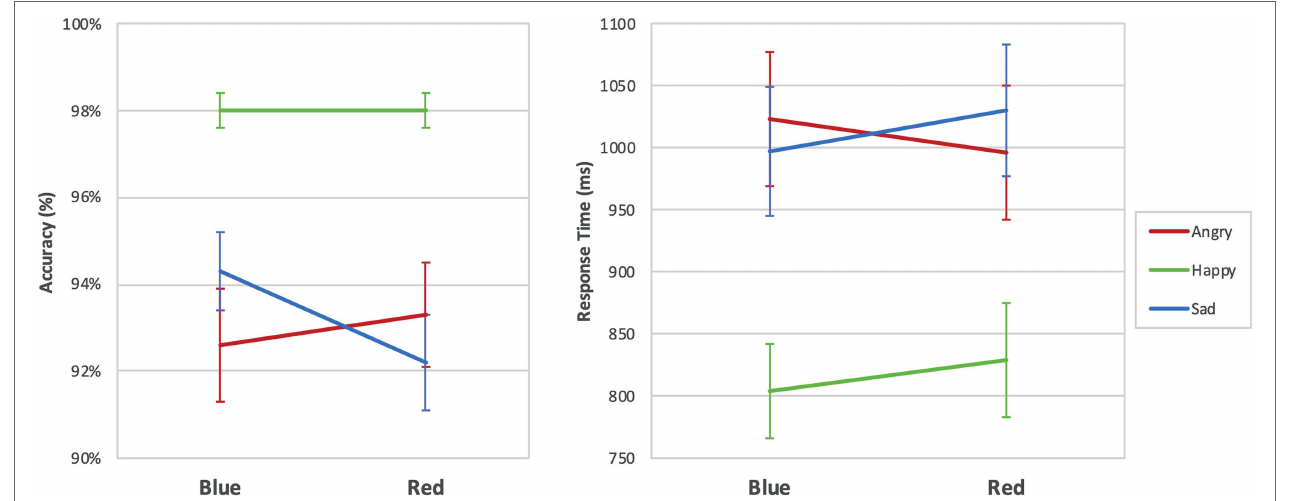
FIGURE 5 | Interaction between color and target word emotion for Experiment